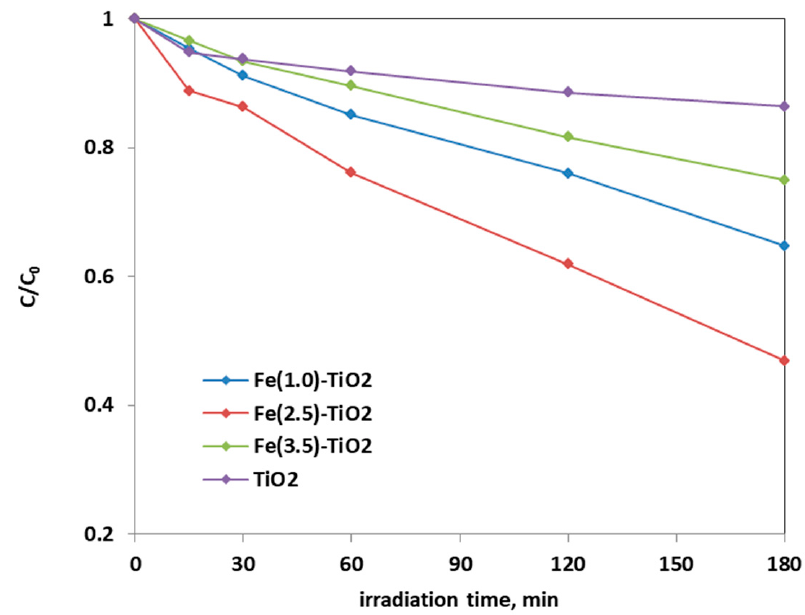
Figure 8. Photocatalytic discoloration of AO7 aqueous solution under visible irradiation as ob- tained with Fe(1.0)-TiO 2 (light blue), Fe(2.5)-TiO 2 (red), Fe(3.5)-TiO 2 (green), and undoped TiO 2 (purple) photocatalysts.